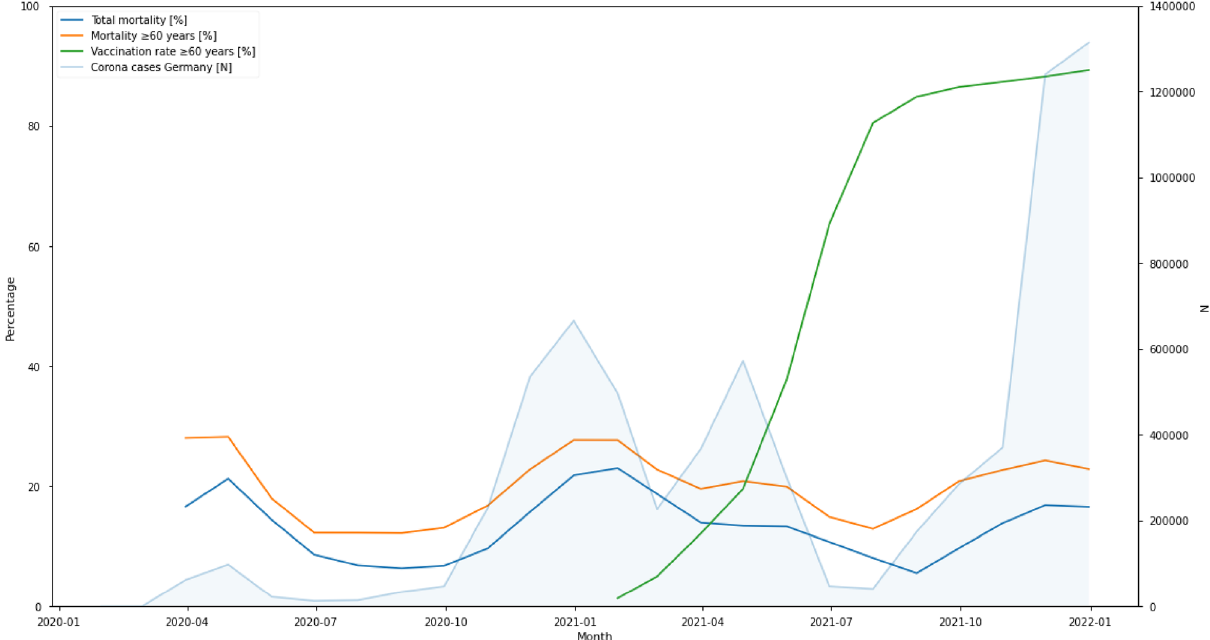
Figure 1. Mortality, vaccination and corona cases over time in Germany. Mortality of in hospital patients compared to COVID-19 vaccination and number of COVID-19 cases in Germany over time. Corona cases in Germany [n]. Fraction of mortality for ≥ 60 years [%]. Vaccinated percentage of age group ≥ 60 years [%] and total mortality [%] over time.